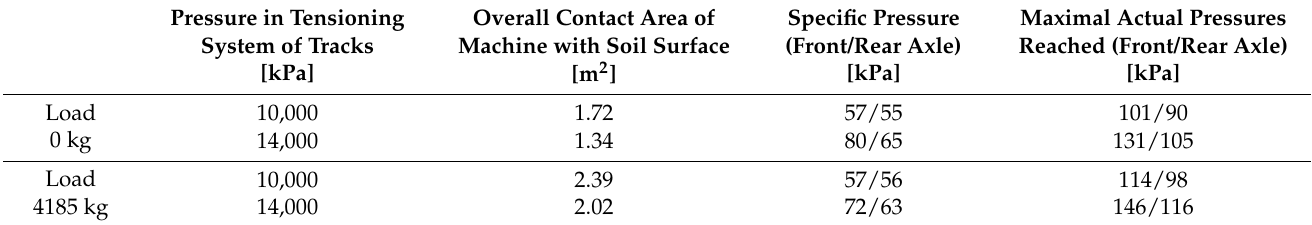
Table 3. Specific pressures of a tracked forwarder on the soil surface and actual pressures at a soil profile depth of 15 cm. Pressure in